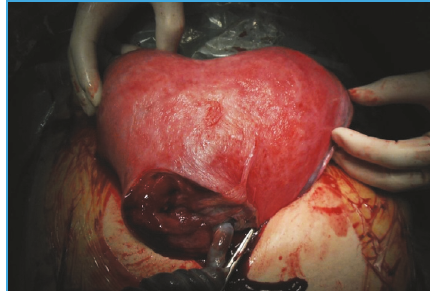
Figure 3: The uterus is repositioned after delivery of the